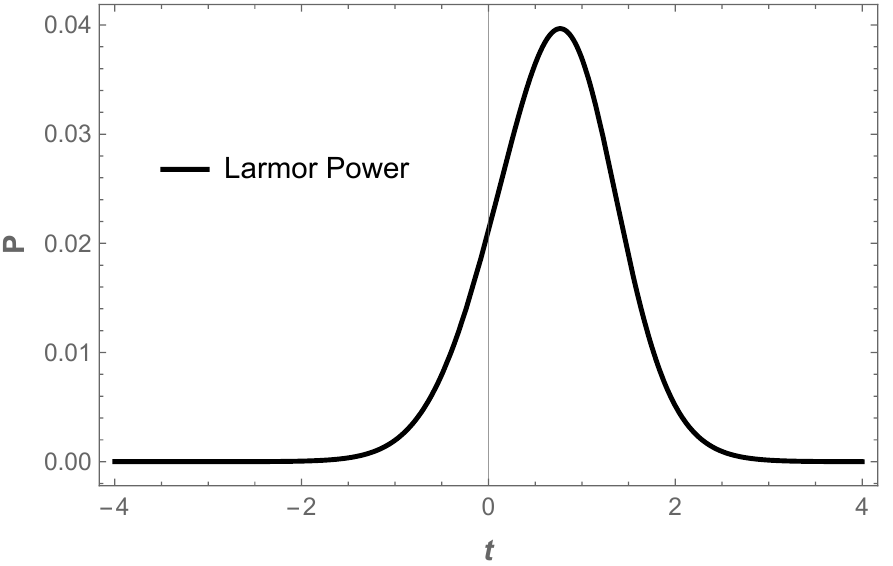
Figure 1. The Larmor power (1) of the Good-Ong (GO) trajectory (6) as a function of time, t , and at final constant speed, s = 0.9, i.e., Equation (7), with acceleration parameter, κ = 1. This plot illustrates that the Larmor power never emits negative energy flux (NEF) and asymptotically dies off, consistent with a physically finite amount of total radiation energy